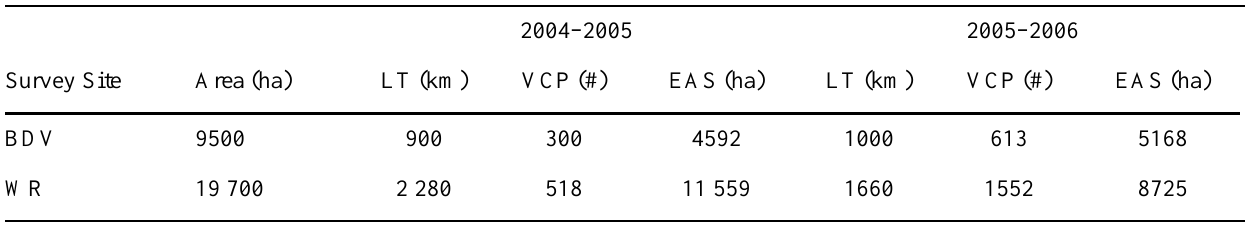
Table 2. Effective areas surveyed (EAS) for Ivory-billed Woodpeckers by visual means during 2 years for tracts along White River (WR) and Bayou de View (BDV), Arkansas (Fig. 2), assuming effective detection distances of 25 m for line transect (LT) surveys and 50 m for variable circular plot (VCP)